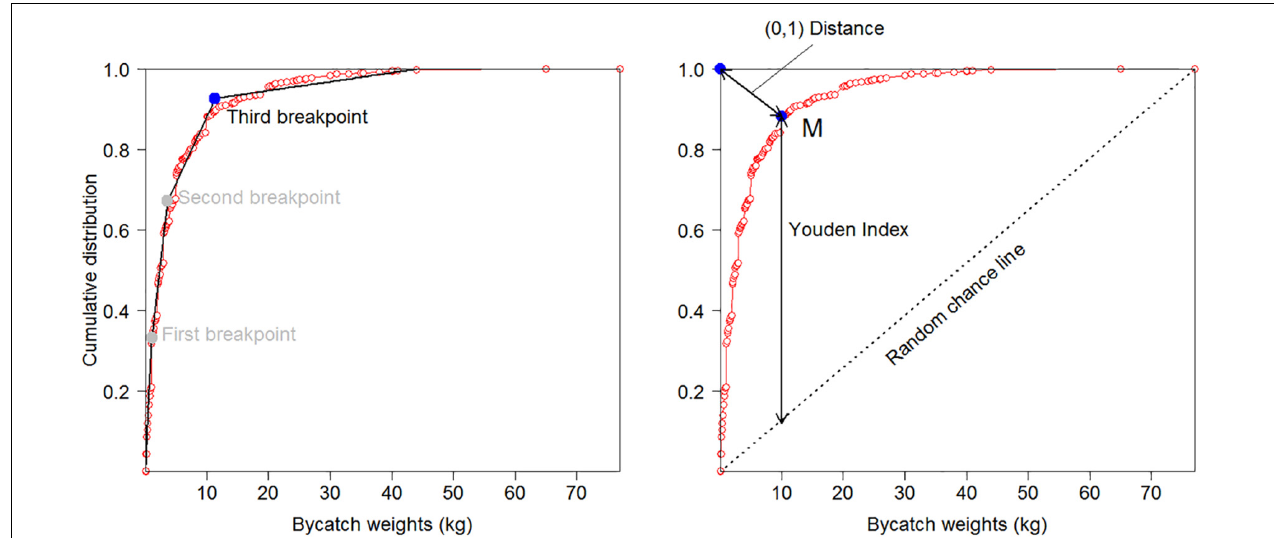
FIGURE 3 | Cumulative distribution curve for the weight of Actiniaria bycatch from the 2008–2018 New Zealand bottom trawl fishery in the SPRFMO Convention Area and three approaches used to distinguish between the initial part of the curve associated with linear increase and the final part of the curve associated with asymptotic decrease (i.e., identification of ecologically relevant reference points): (1) the third breakpoint in a 3-parameter segmented regression (left-hand panel); (2) the point on the curve that is closest to the top-left corner [(0,1) Distance, right-hand panel]; and (3) the point on the curve that maximizes the distance between the curve and a random chance line drawn between the extreme points on the curve (Youden Index, right hand